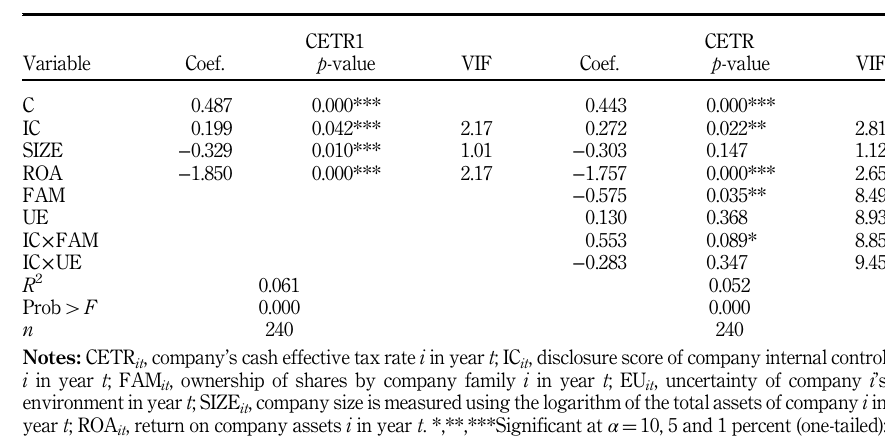
Table II. Effect of internal control on tax